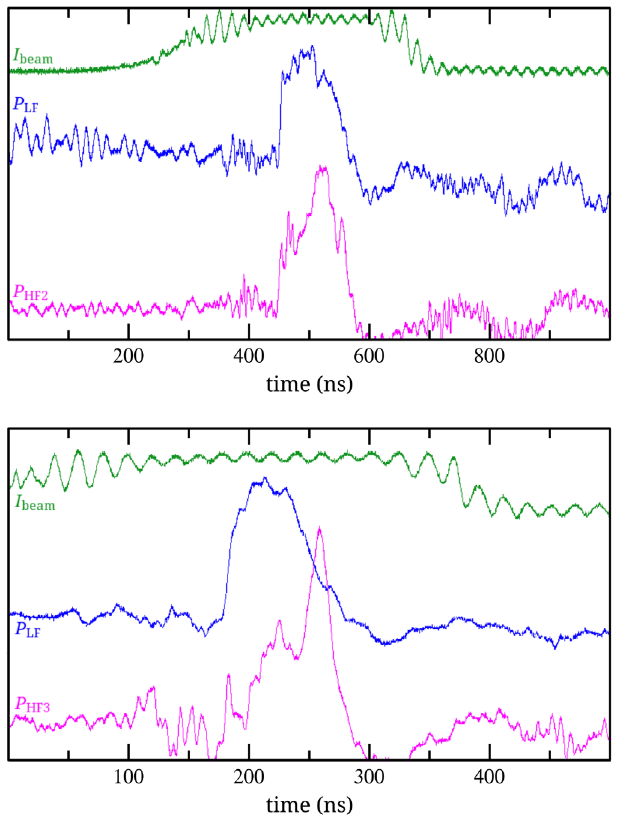
FIG. 4. The results of experimental studies of the FEM multiplier based on the LIU-3000 accelerator. Typical oscillo- scope traces of the beam current I and the rf pulses in the two- beam wave generation regime of the fundamental harmonic at 24 GHz ( P LF ) with (a) the second harmonic at 48 GHz ( P HF 2 ) and (b) the third harmonic at 72 GHz ( P HF 3